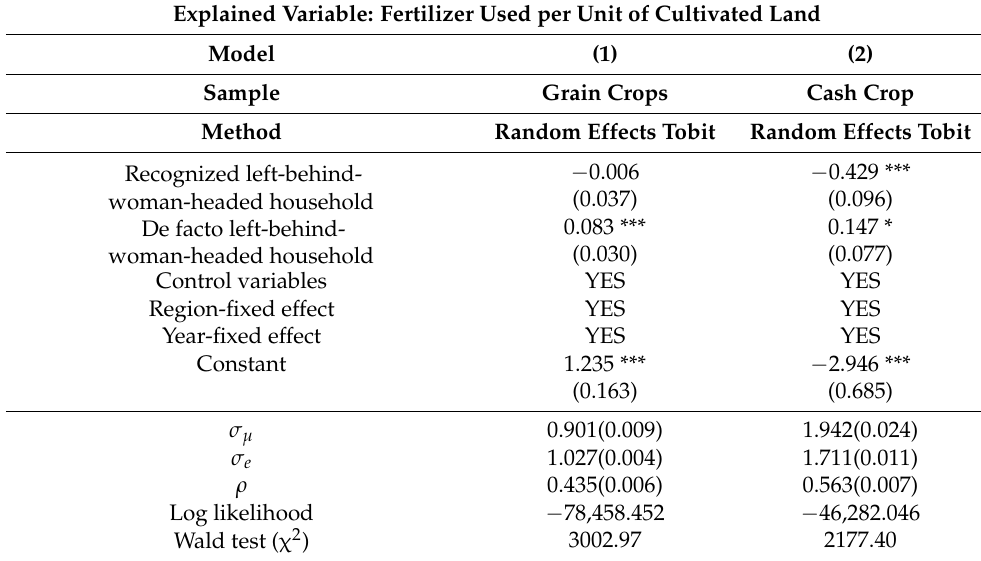
Table 2. Impacts of left-behind women on fertilizer use with different crop types. Explained Variable: Fertilizer Used per Unit of Cultivated